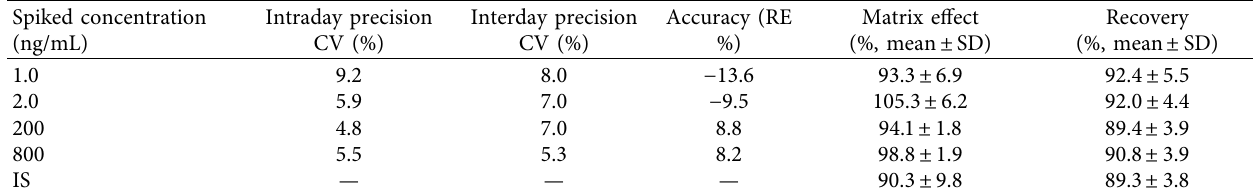
Table 1: Precision, accuracy, matrix effect, and recovery for analysis of VS-5584 in rat plasma ( n �